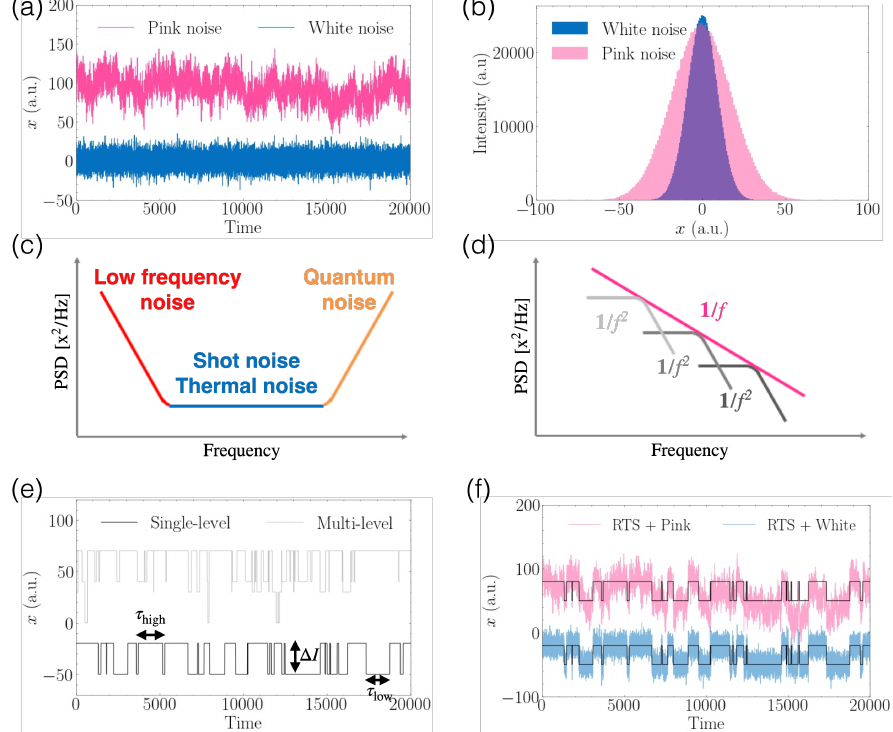
Figure 2. ( a ) Gaussian pink noise (top, pink) and white noise (bottom, blue) of a signal x in the time domain and their histograms ( b ). ( c ) Three kinds of noises by power spectral density (PSD) of parameter x in the frequency domain. ( d ) 1/ f and 1/ f 2 noises in the frequency domain; 1/ f noise is thought of as the summing of 1/ f 2 noises. ( e ) Representative single-level (bottom) and multi-level (top) random telegraph signals (RTSs) in the time domain. ( f ) A single-level RTS mixed with pink noise (top, pink) and white noise (bottom,